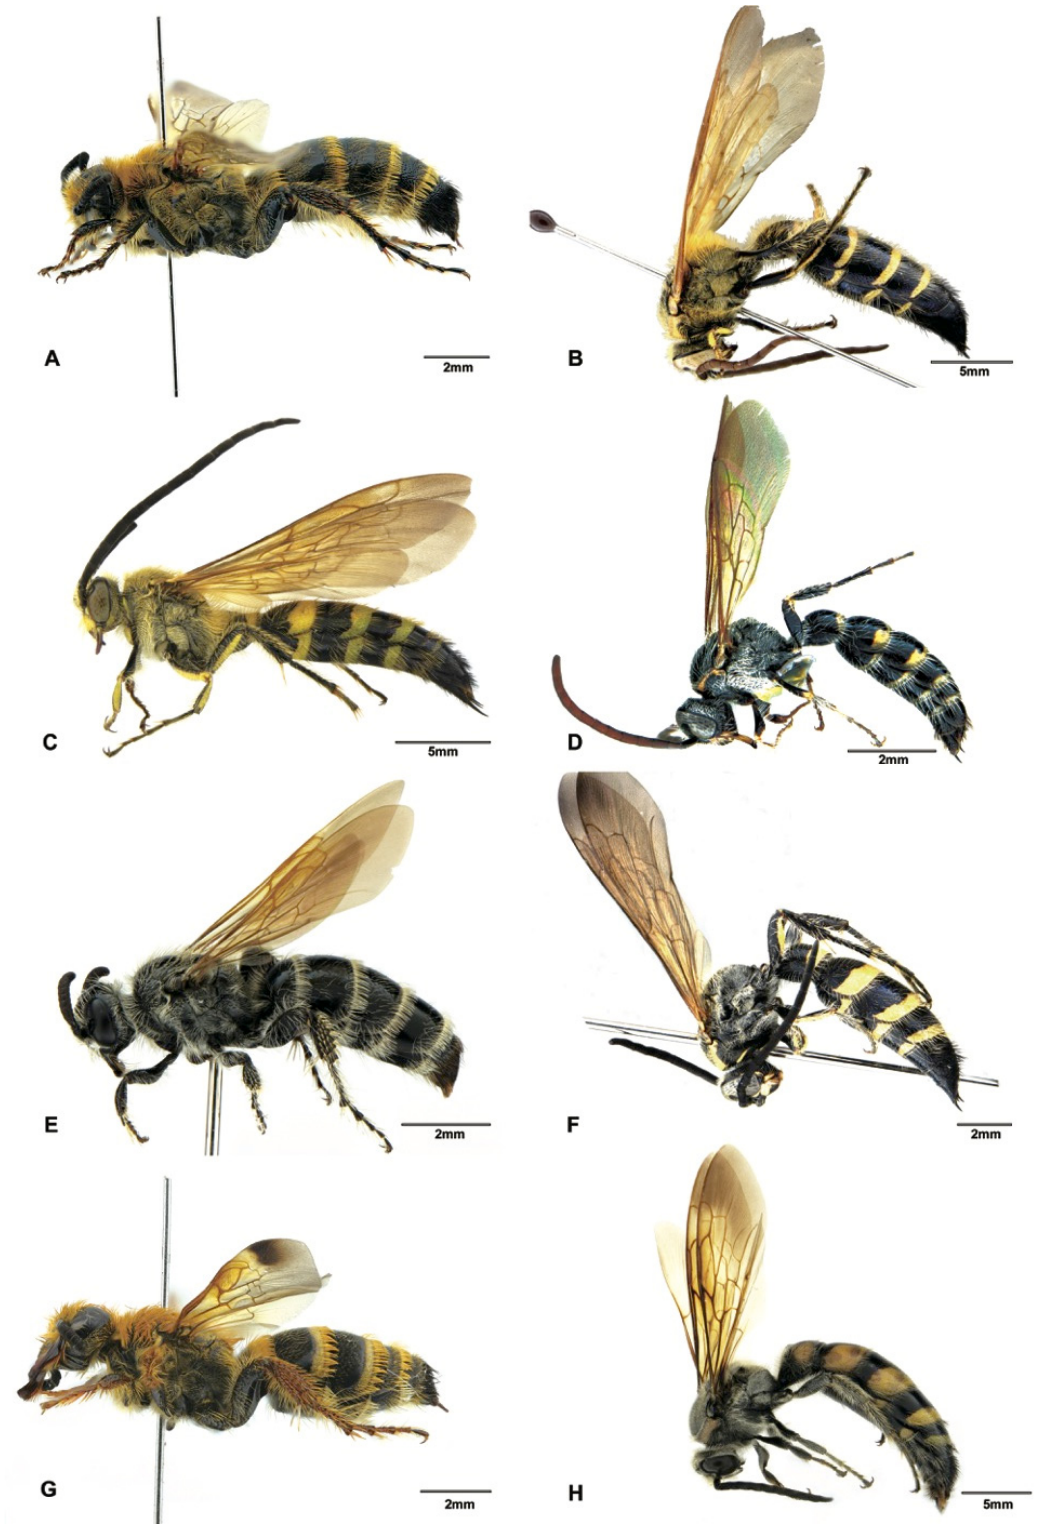
Figure 6. Habitus. ( A ) Megacampsomeris prismatica (Smith, 1855), female (SCAU3043653); ( B ) Megacampsomeris pulchrivestita (Cameron, 1902), male (NZ4760); ( C ) Megacampsomeris shillongensis Betrem, 1928, male (SCAU3043655); ( D ) Micromeriella marginella (Klug, 1810), male (SCAU3043668); ( E ) Micromeriella marginella (Klug, 1810), female (SCAU3043667); ( F ) Phaler- imeris phalerata (Saussure,1858), male (SCAU3043685); ( G ) Phalerimeris phalerata (Saussure,1858), female (SCAU3043686); ( H ) Sericocampsomeris flavomacula Gupta & Jonathan, 1989, male